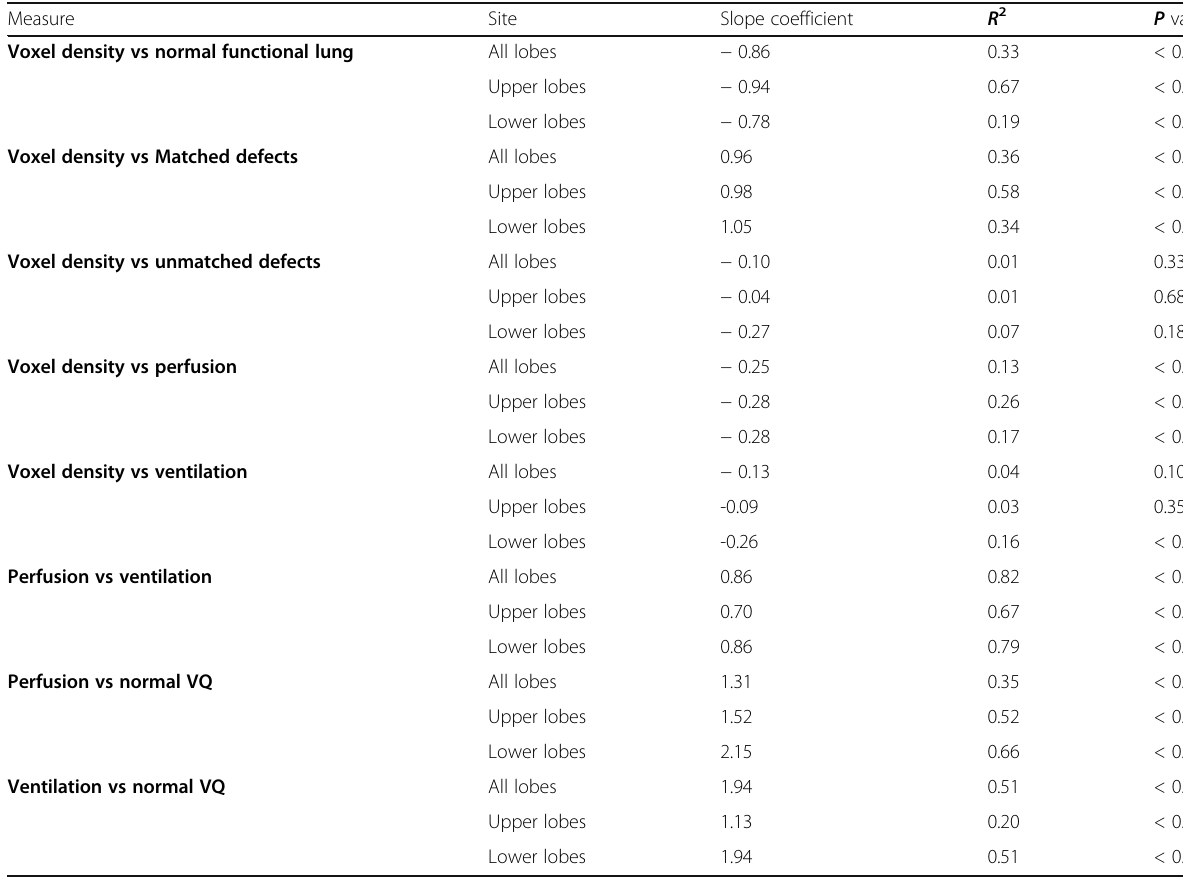
Table 2 Voxel density and functional lung mapping Measure Site Slope coefficient R 2 Voxel density vs normal functional lung All lobes